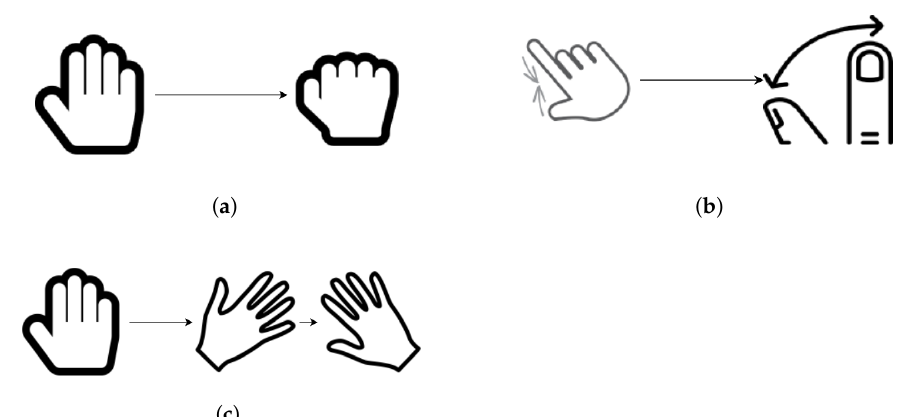
Figure 7. Exercise protocols. ( a ) Grasping, ( b ) Pinching, ( c )